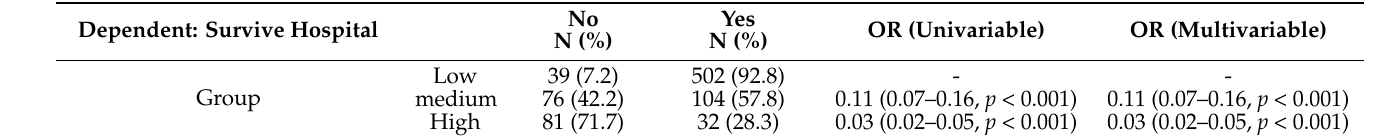
Table 8. The total in-hospital survival odds-ratio relations for GRAM risk